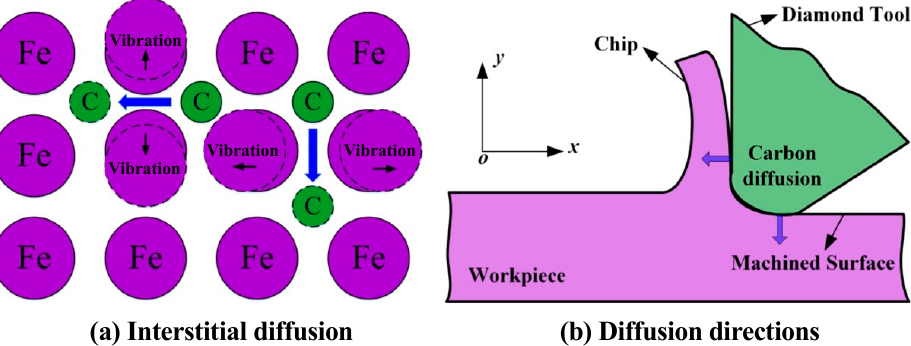
Figure 19. Diffusion process of carbon atoms in cutting ferrous material, reprinted with permission from Ref. [124] 2018, Elsevier. ( a ) Interstitial diffusion of diamond graphitization. ( b ) The direction of diffusion of diamond graphitization to the workpiece.